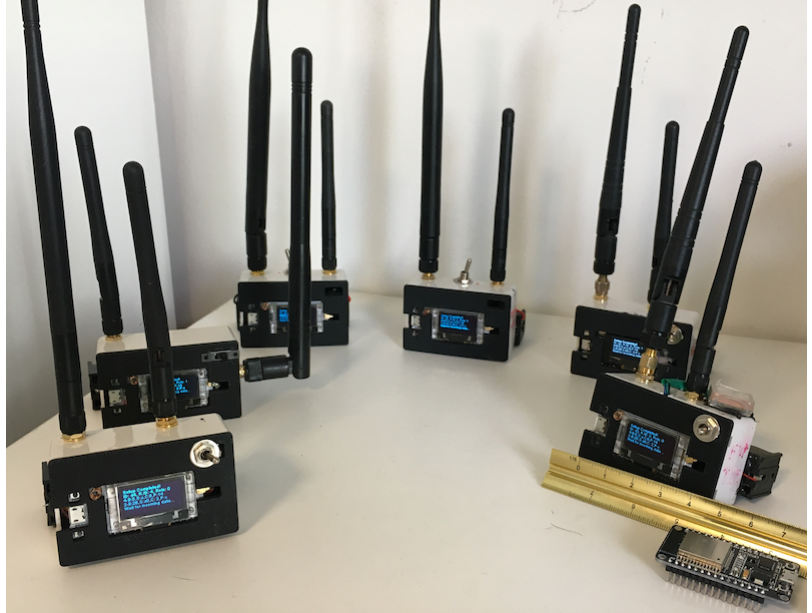
Figure 9. Several nodes were built to take part in the WSN field experiments.